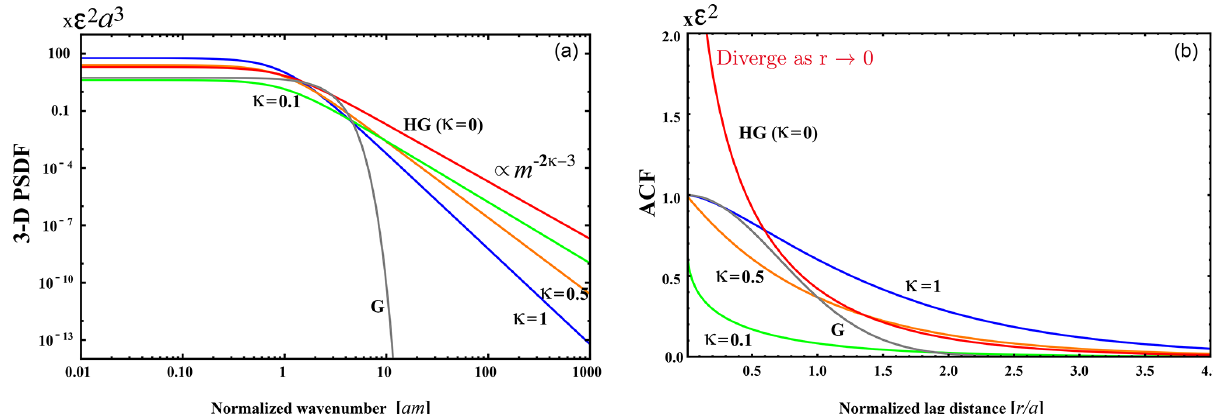
Figure 1. (a) Log–log plot of PSDF vs. wavenumber m in 3-D space (von Kármán type, κ = 0 . 1, 0.5, and 1; Henyey–Greenstein type, HG, κ = 0; Gaussian type, G). (b) Linear plot of ACF vs. lag distance r